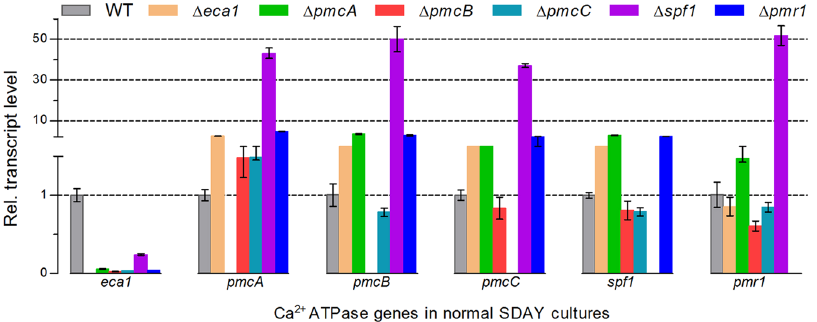
Figure 1. Relative transcript levels of CA genes in the 3-day-old SDAY cultures of their deletion mutants versus the wild-type B . bassiana strain. Note that the transcript of each CA gene was undetectable in its deletion mutant and that the deletion of each gene resulted in drastic transcript changes of some others. Error bars: SD of the mean from three cDNA samples of each strain detected in qRT-PCR experiments with paired primers (Table S1).